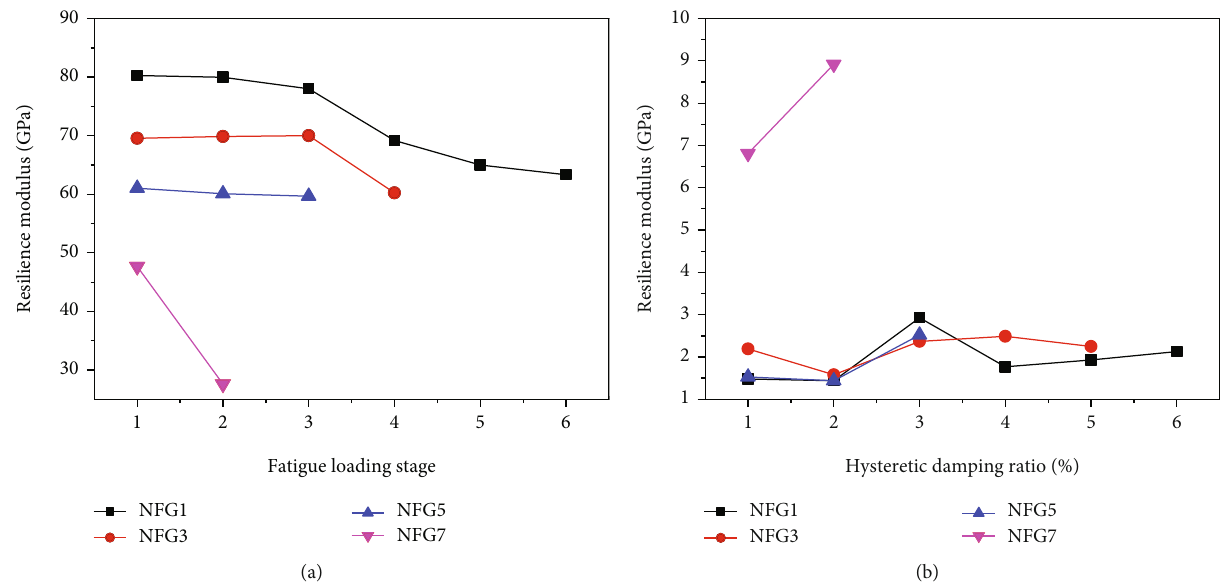
Figure 6: Comparison of the (a) dynamic elastic modulus and (b) damping ratio for the samples with di ff erent natural fracture volume